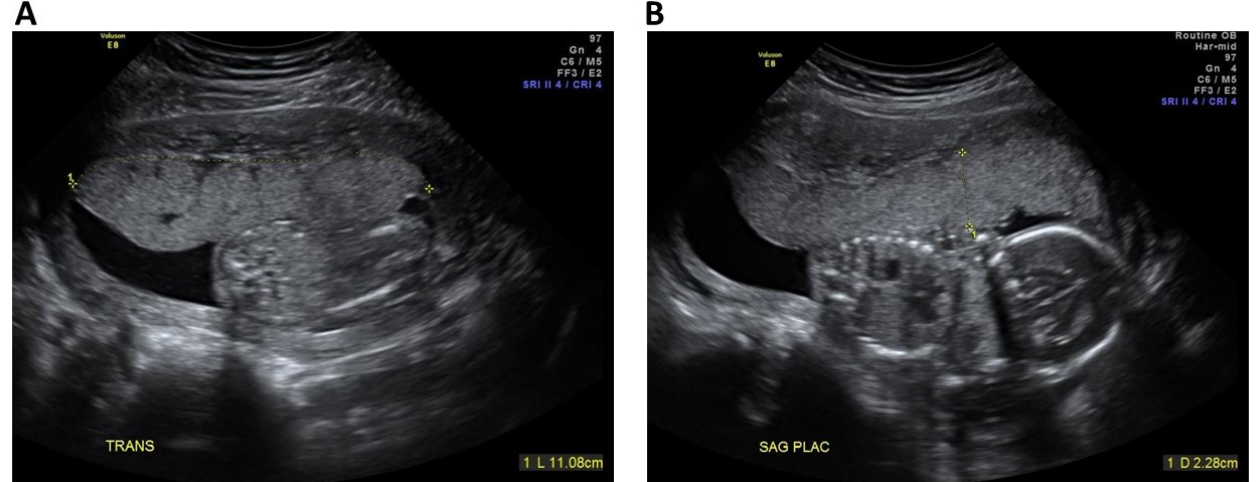
Figure 1. Illustration of measurement of placental dimensions. The figures illustrate the measure- ment of placental length ( A ) and thickness ( B ) in patient undergoing placental assessment at 18 weeks’ gestation. Following initial axial and sagittal placental scan, the maximal placental length using curved linear method at the basal plate, and maximal thickness.